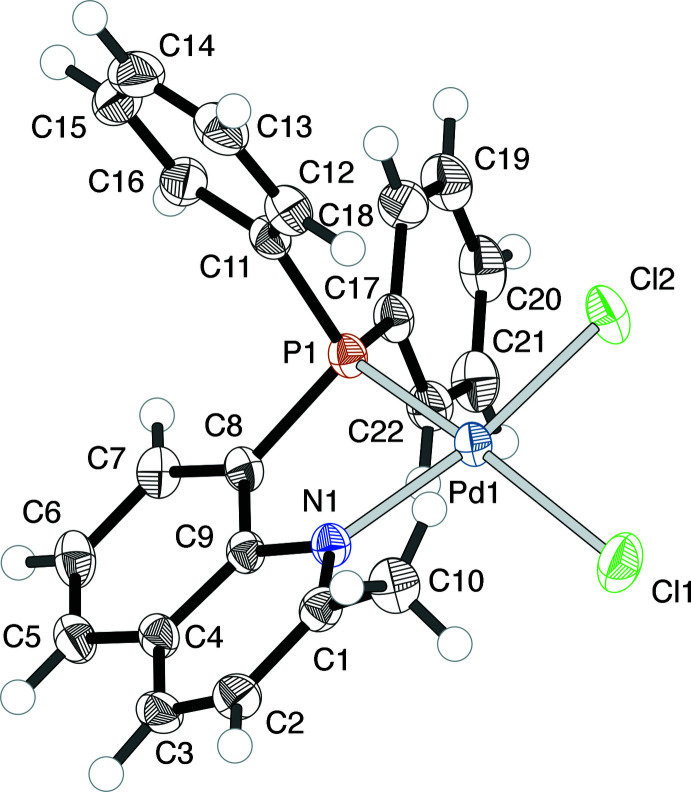
The mol­ecular structure of [PdCl2(PQMe)] (1), showing the atom-numbering scheme and displacement ellipsoids at the 50% probability level.